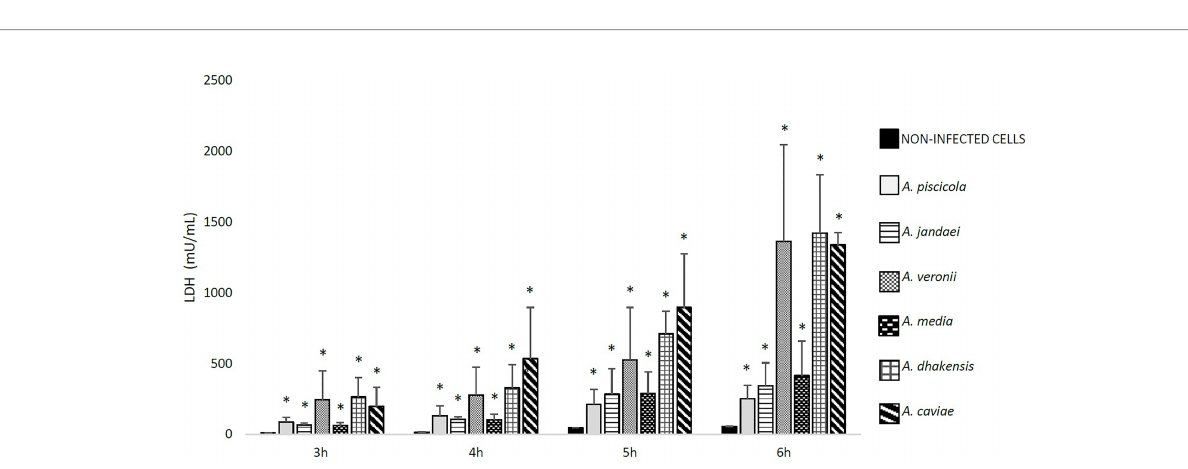
FIGURE 2 | Detected THP-1 cell damage induced by the six different Aeromonas spp. at multiplicity of infection (MOI) 20 and at different exposure times in relation to the non-infected cells, measured by the release of lactate dehydrogenase (LDH) enzyme. Asterisks indicate statistical signi fi cance *p < 0.05.